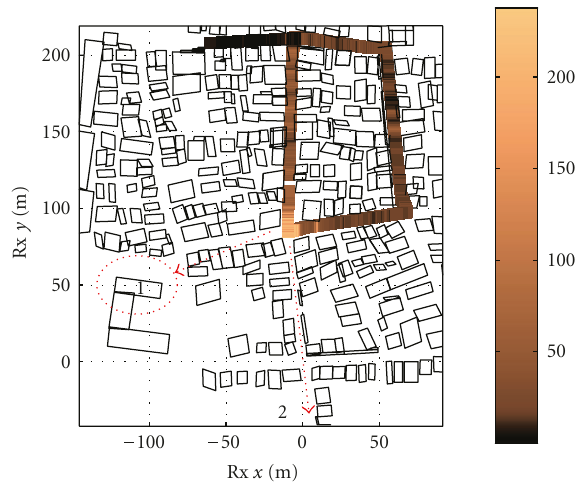
Figure 6: Path length variation in m, where the arrows indicate the position of far clusters (no. 2 not on the map).